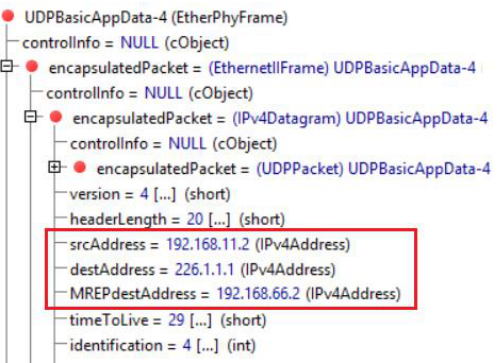
Figure 14. Encapsulated EM-REP packet.